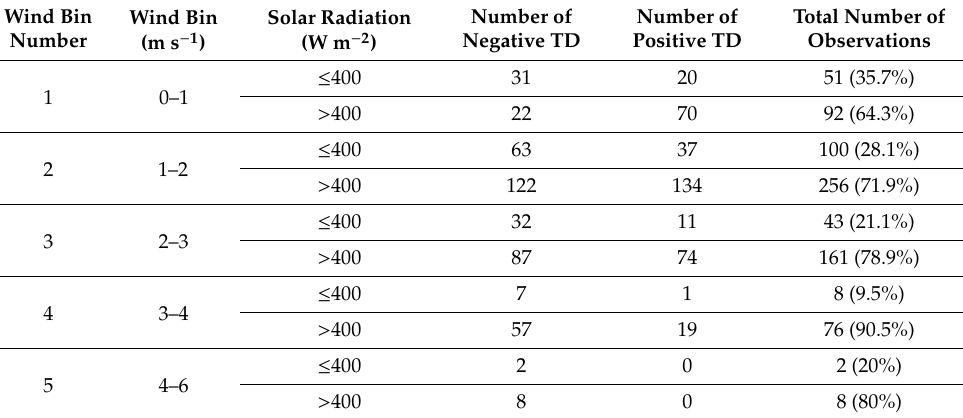
Table 5. Number of positive, negative, and total Temperature Di ff erence (TD = T iMET − T 2m ) Table 5, zero values of TD were not counted (there were very